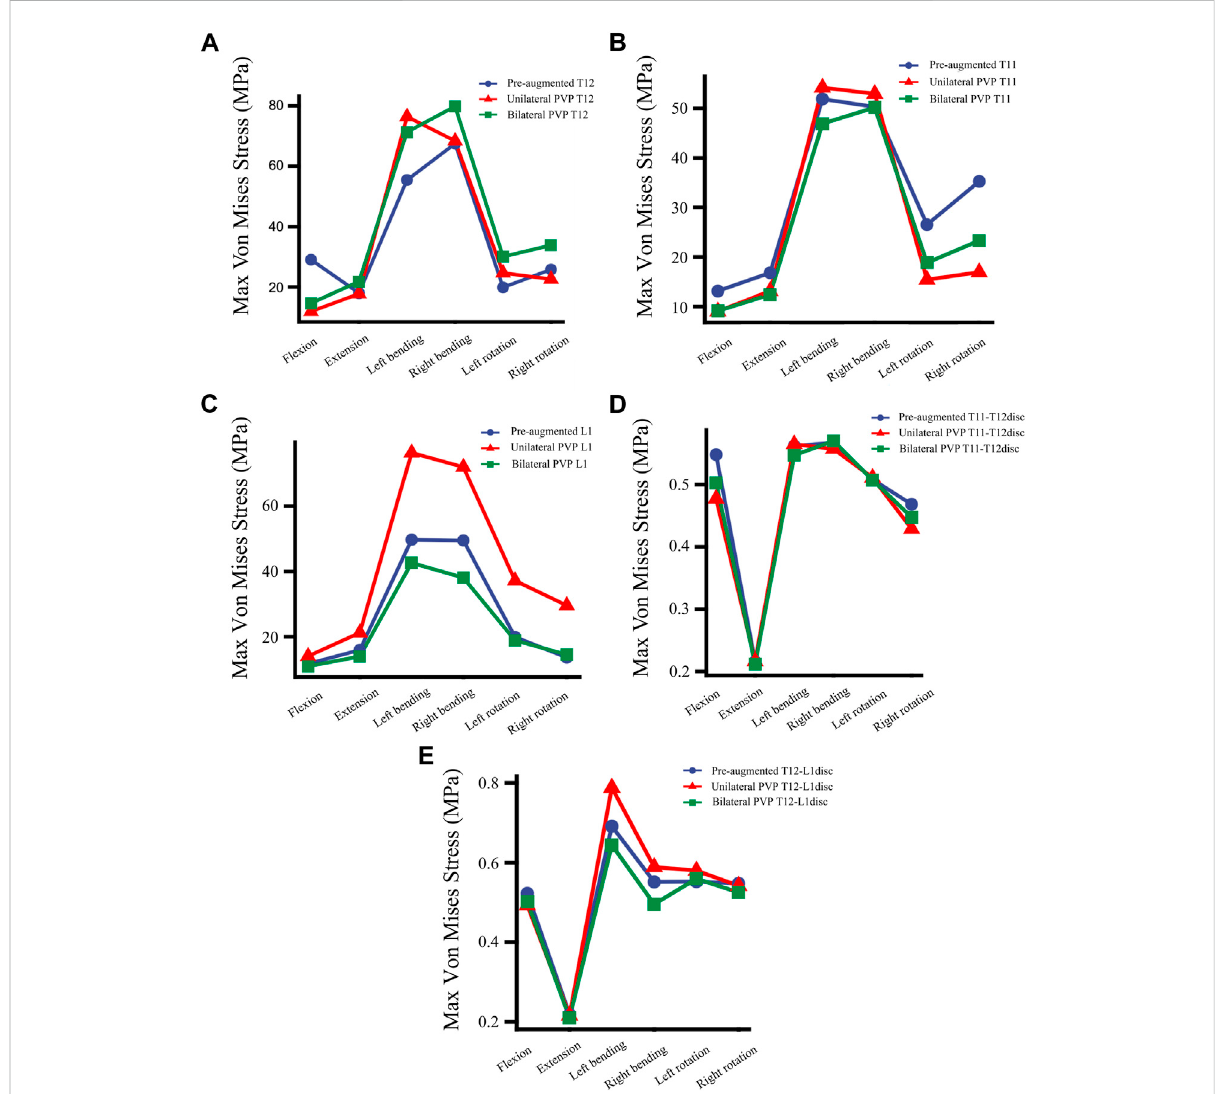
FIGURE 6 The maximum von Mises stress at vertebrae and discs. (A) The maximum von Mises stress at T12 in a fractured model (Pre-augmented), UPVP, andBPVP under fl exion,extension,left/rightbending, andleft/right torsion, (B) themaximum vonMises stressatT11 inafractured model, UPVP, and BPVP under fl exion, extension, left/right bending, and left/right torsion, (C) the maximum von Mises stress on L1 in a fractured model, UPVP, and BPVP under fl exion, extension, left/right bending, and left/right torsion, (D) the maximum von Mises stress on the T11-T12disc in a fractured model,UPVP, andBPVPunder fl exion,extension, left/rightbending,andleft/righttorsion, (E) themaximumvonMisesstressontheT12-L1discinthe fractured model, UPVP, and BPVP under fl exion, extension, left/right bending, and left/right